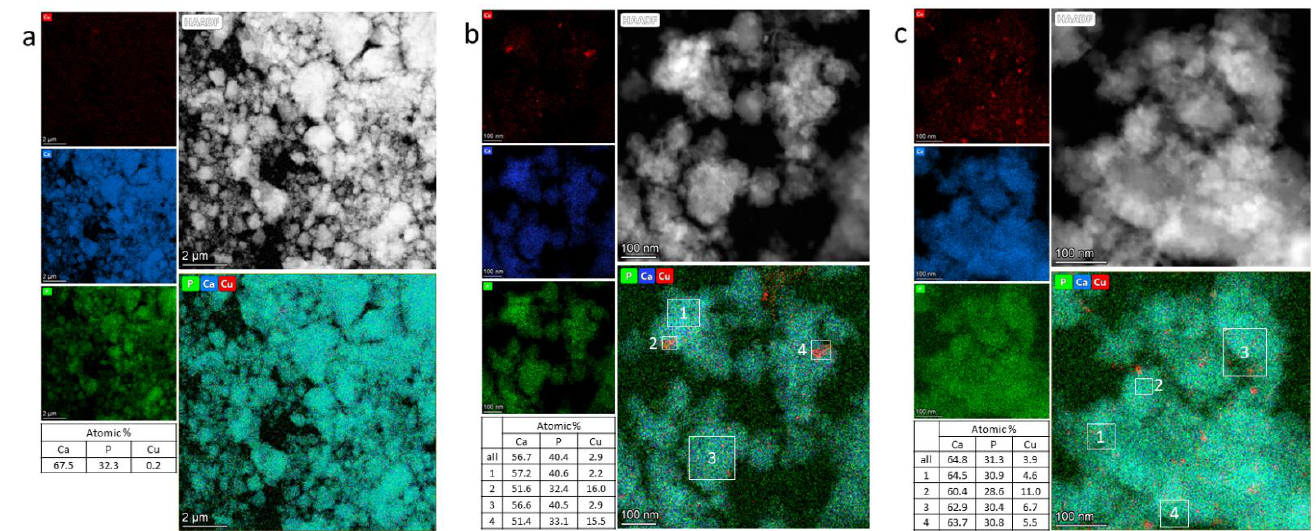
Figure 4. Distribution maps of elements across particles in synthesized samples 0.0Cu ( a ), 0.5Cu-Ca ( b ), and 0.5Cu-OH ( c ).